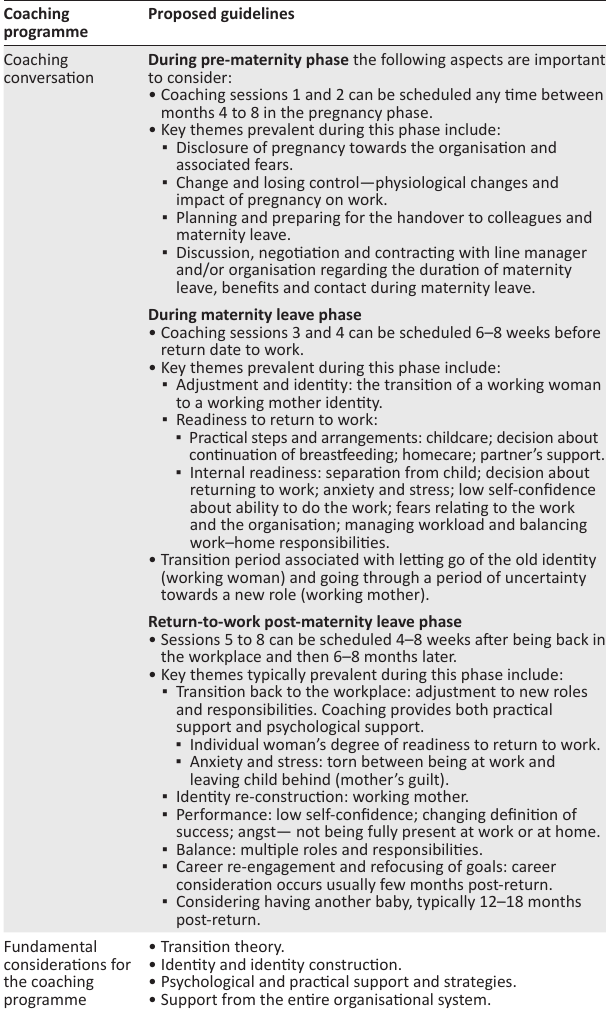
TABLE 4: Guidelines for implementing a maternity transition coaching